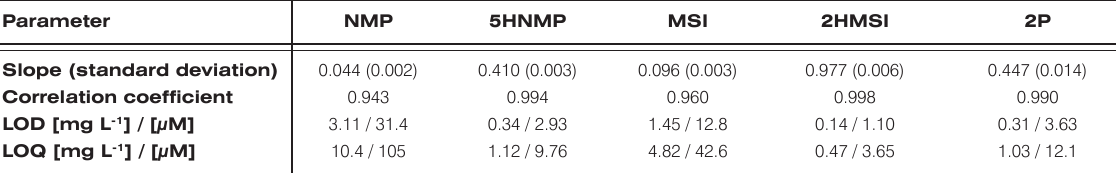
Table 2. Slope of linear calibration curve, correlation coefficient, LOD, and LOQ of NMP and its metabolites in urine samples.